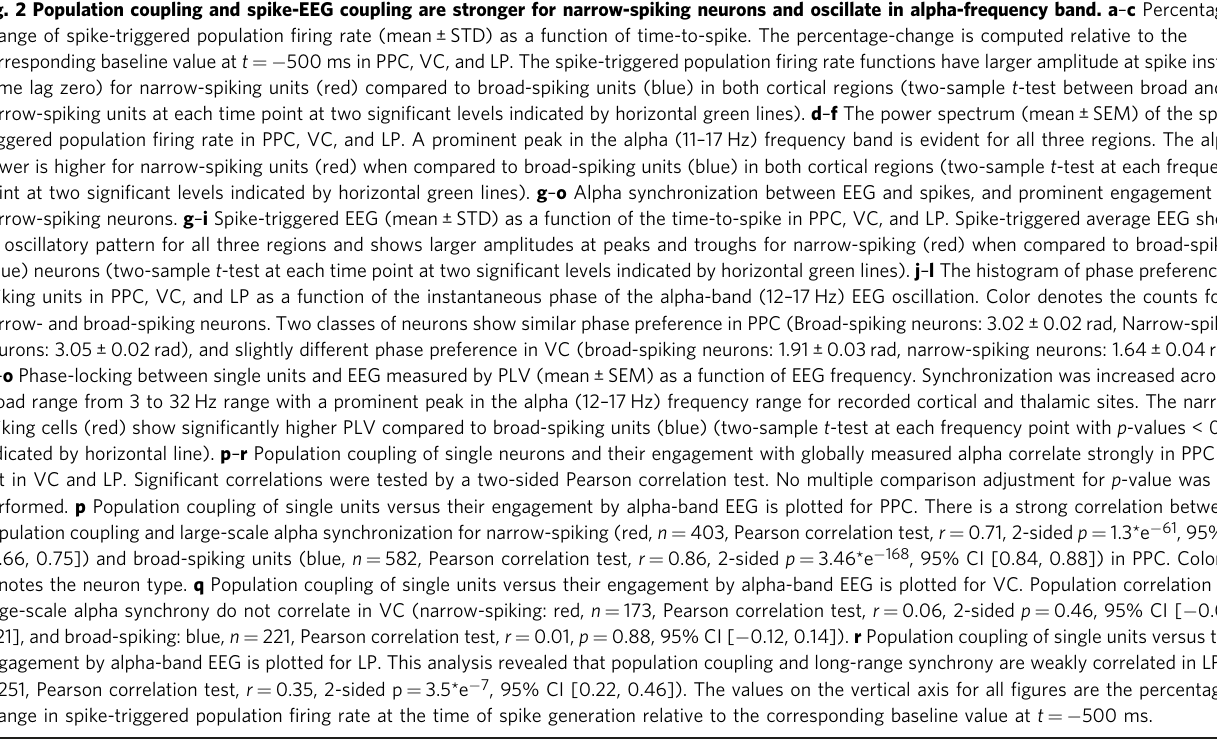
Fig. 2 Population coupling and spike-EEG coupling are stronger for narrow-spiking neurons and oscillate in alpha-frequency band. a – c Percentage- change of spike-triggered population fi ring rate (mean ± STD) as a function of time-to-spike. The percentage-change is computed relative to the corresponding baseline value at t = − 500 ms in PPC, VC, and LP. The spike-triggered population fi ring rate functions have larger amplitude at spike instant (time lag zero) for narrow-spiking units (red) compared to broad-spiking units (blue) in both cortical regions (two-sample t -test between broad and narrow-spiking units at each time point at two signi fi cant levels indicated by horizontal green lines). d – f The power spectrum (mean ± SEM) of the spike- triggered population fi ring rate in PPC, VC, and LP. A prominent peak in the alpha (11 – 17 Hz) frequency band is evident for all three regions. The alpha power is higher for narrow-spiking units (red) when compared to broad-spiking units (blue) in both cortical regions (two-sample t -test at each frequency point at two signi fi cant levels indicated by horizontal green lines). g – o Alpha synchronization between EEG and spikes, and prominent engagement of narrow-spiking neurons. g – i Spike-triggered EEG (mean ± STD) as a function of the time-to-spike in PPC, VC, and LP. Spike-triggered average EEG shows an oscillatory pattern for all three regions and shows larger amplitudes at peaks and troughs for narrow-spiking (red) when compared to broad-spiking (blue) neurons (two-sample t -test at each time point at two signi fi cant levels indicated by horizontal green lines). j – l The histogram of phase preference of spiking units in PPC, VC, and LP as a function of the instantaneous phase of the alpha-band (12 – 17 Hz) EEG oscillation. Color denotes the counts for narrow- and broad-spiking neurons. Two classes of neurons show similar phase preference in PPC (Broad-spiking neurons: 3.02 ± 0.02 rad, Narrow-spiking neurons: 3.05 ± 0.02 rad), and slightly different phase preference in VC (broad-spiking neurons: 1.91 ± 0.03 rad, narrow-spiking neurons: 1.64 ± 0.04 rad). m – o Phase-locking between single units and EEG measured by PLV (mean ± SEM) as a function of EEG frequency. Synchronization was increased across a broad range from 3 to 32 Hz range with a prominent peak in the alpha (12 – 17 Hz) frequency range for recorded cortical and thalamic sites. The narrow- spiking cells (red) show signi fi cantly higher PLV compared to broad-spiking units (blue) (two-sample t -test at each frequency point with p -values < 0.05 indicated by horizontal line). p – r Population coupling of single neurons and their engagement with globally measured alpha correlate strongly in PPC but not in VC and LP. Signi fi cant correlations were tested by a two-sided Pearson correlation test. No multiple comparison adjustment for p -value was performed. p Population coupling of single units versus their engagement by alpha-band EEG is plotted for PPC. There is a strong correlation between population coupling and large-scale alpha synchronization for narrow-spiking (red, n = 403, Pearson correlation test, r = 0.71, 2-sided p = 1.3*e − 61 , 95% CI [0.66, 0.75]) and broad-spiking units (blue, n = 582, Pearson correlation test, r = 0.86, 2-sided p = 3.46*e − 168 , 95% CI [0.84, 0.88]) in PPC. Color denotes the neuron type. q Population coupling of single units versus their engagement by alpha-band EEG is plotted for VC. Population correlation and large-scale alpha synchrony do not correlate in VC (narrow-spiking: red, n = 173, Pearson correlation test, r = 0.06, 2-sided p = 0.46, 95% CI [ − 0.09, 0.21], and broad-spiking: blue, n = 221, Pearson correlation test, r = 0.01, p = 0.88, 95% CI [ − 0.12, 0.14]). r Population coupling of single units versus their engagement by alpha-band EEG is plotted for LP. This analysis revealed that population coupling and long-range synchrony are weakly correlated in LP ( n = 251, Pearson correlation test, r = 0.35, 2-sided p = 3.5*e − 7 , 95% CI [0.22, 0.46]). The values on the vertical axis for all fi gures are the percentage- change in spike-triggered population fi ring rate at the time of spike generation relative to the corresponding baseline value at t = − 500